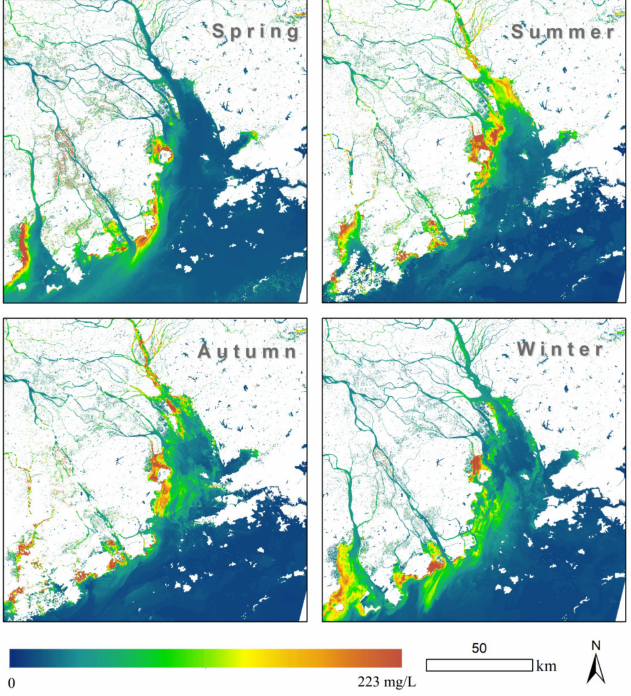
Figure 15. Distribution map of seasonal change of SSC in the